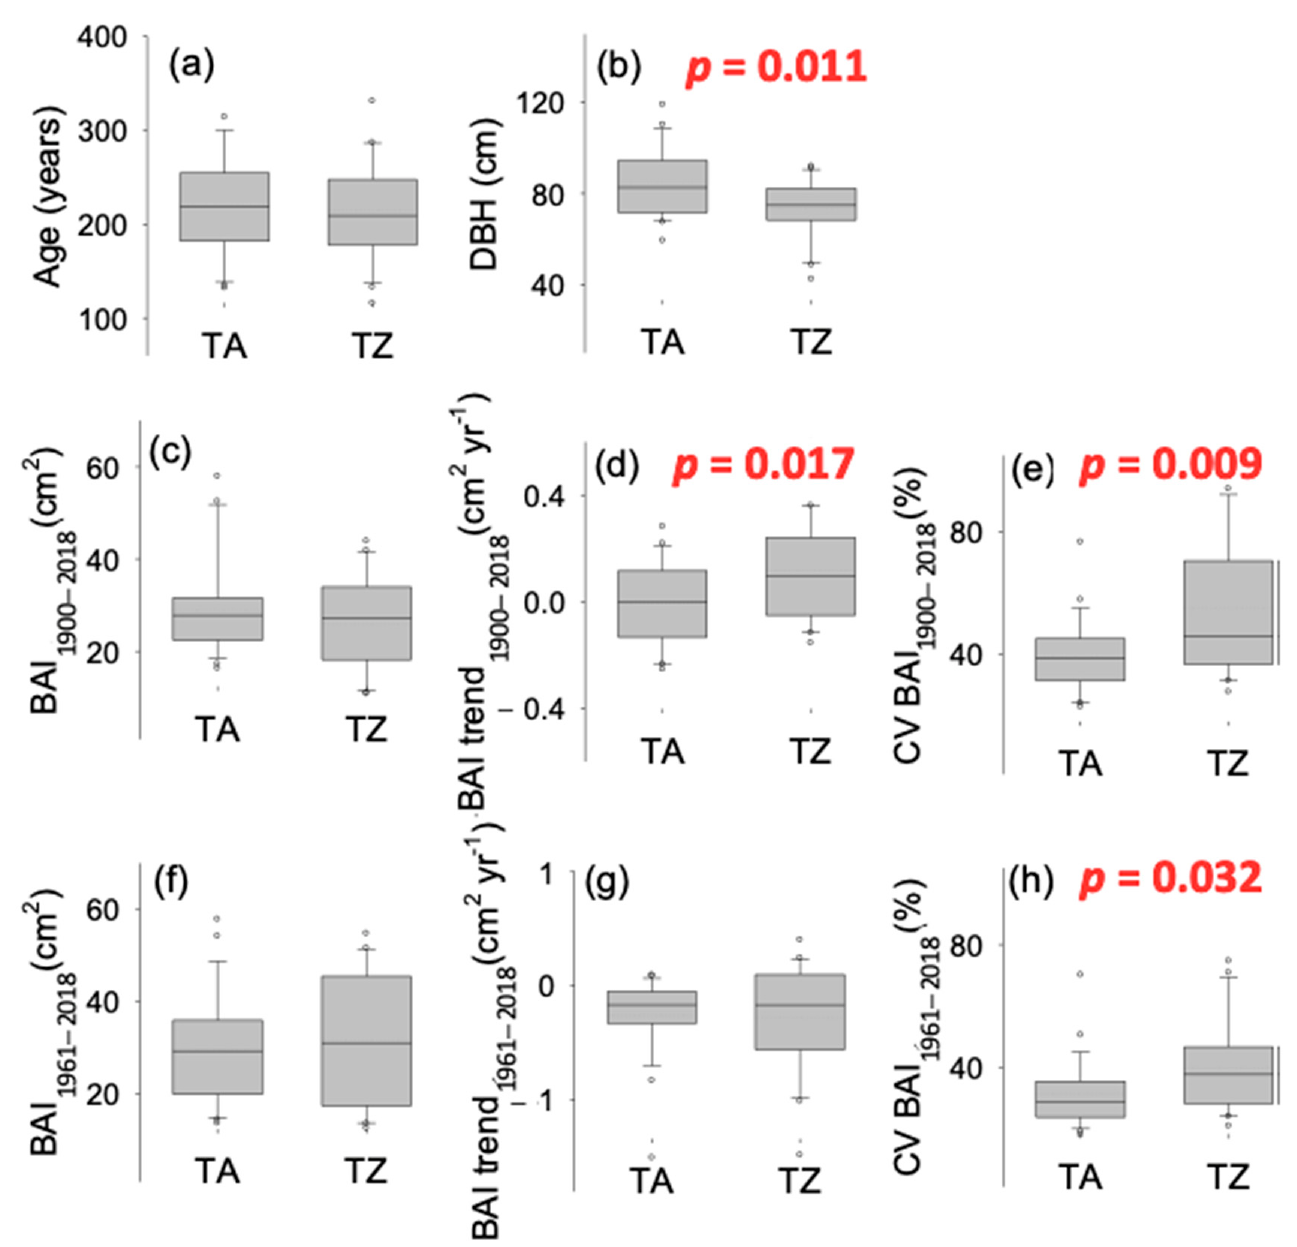
Figure 1. Comparison of tree-scale growth patterns estimated as the basal area increments (BAI) of tree rings obtained in Abies marocana for Talassemtane (TA) and Tazaot (TZ). Tree age ( a ) was estimated at coring height, according to tree-ring dating. DBH ( b ) indicates the tree diameter at 1.3 m from the ground. Mean growth was computed comparing the periods 1900–2018 ( c ) and 1961–2018 ( f ). BAI trend ( d , g ) was estimated as the slope of BAI against the time. CV ( e , h ) indicates the coefficient of variation, estimated as (100*) the ratio of the BAI standard deviation divided by the mean. Significant p -values for ANOVA are indicated. Table 1. Temporal trends observed in seasonal and annual total precipitation and mean temperature according to Mann–Kendall statistic for the period of 1921–2021 and 1961–2021. Seasons are noted as winter (Wi), spring (Sp), summer (Su), and autumn (Au), including December–February, March– May, June–August, and September–November, respectively. Annual estimates consider the hydro- logical year (prior September to current August). Mean change in each variable over the considered time span was computed, only if the slope was statistically significant, by multiplying the slope estimate (mm or °C year − 1 ) per the number of years.